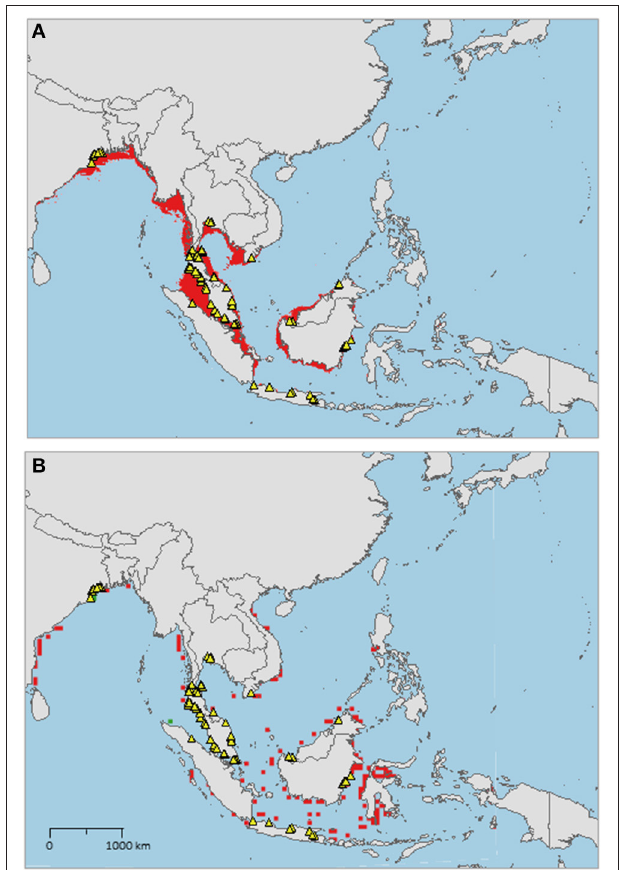
FIGURE 3 | Distribution maps for Carcinoscorpius rotundicauda with environmentally unique points, indicating the sampled distribution range for the species. Upper map (A) shows present-day projections of suitable habitat in red based on consensus of Maxent and SVM algorithms. Lower map (B) shows changes between the present-day and 2050 projections of suitable habitat based of consensus of Maxent and SVM algorithms, with green cells indicating loss of suitable habitat and red cells indicating gain of suitable habitat. Support values for the individual models are given in Table 3 .